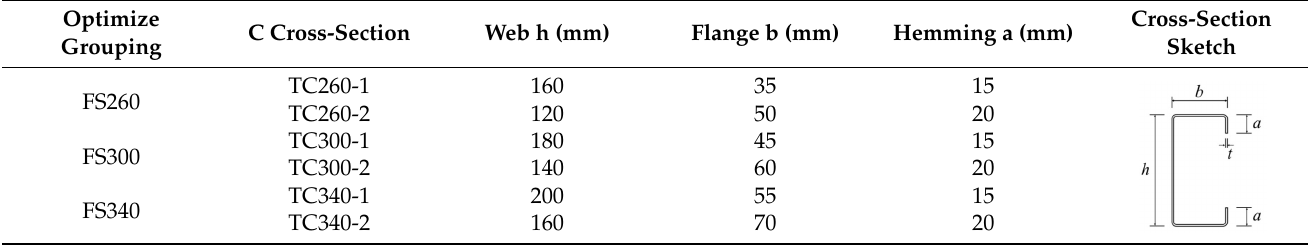
Figure 17. FS340 FE results. Table 3. Parameters of C cross-section.